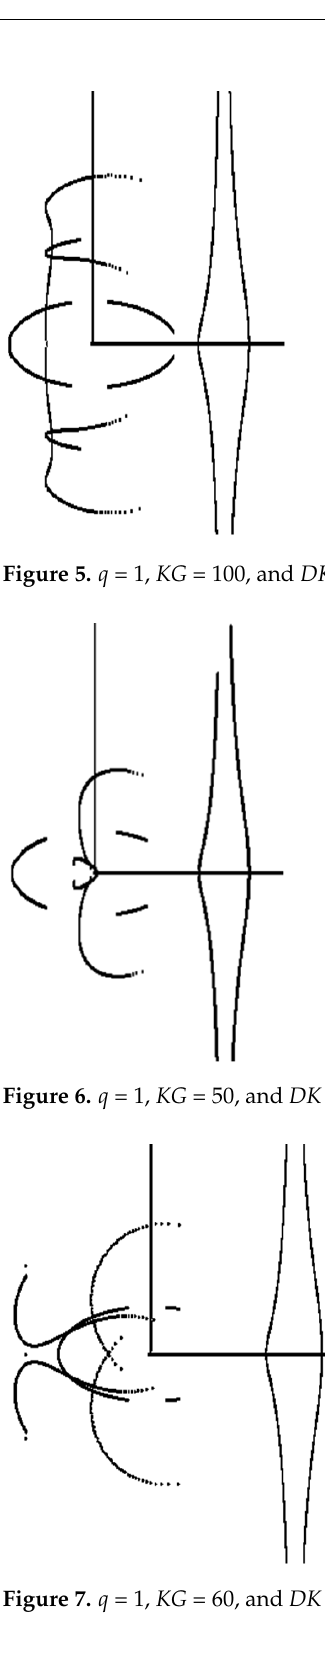
Figure 8. q = 1, KG = 60, and DK = 220. Figure 9. q = 1, KG = 100, and DK = 200